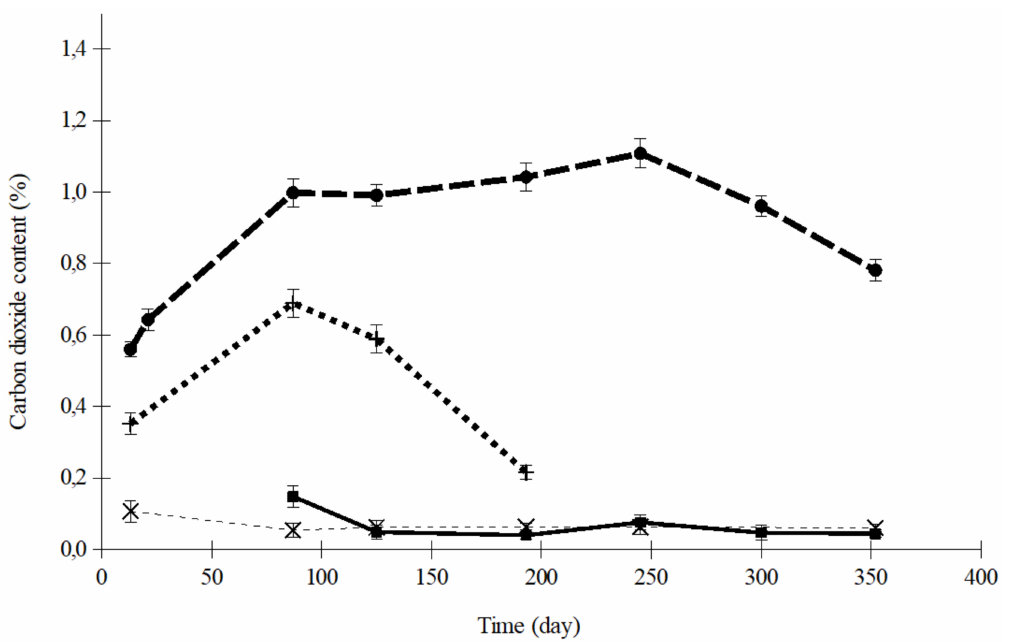
Figure 4. CO 2 concentration in trays containing dried apricots sealed with air (PA/PP: × , 5 ◦ C; +, 35 ◦ C; OPA/PE: (cid:4) , 5 ◦ C; • , 35 ◦